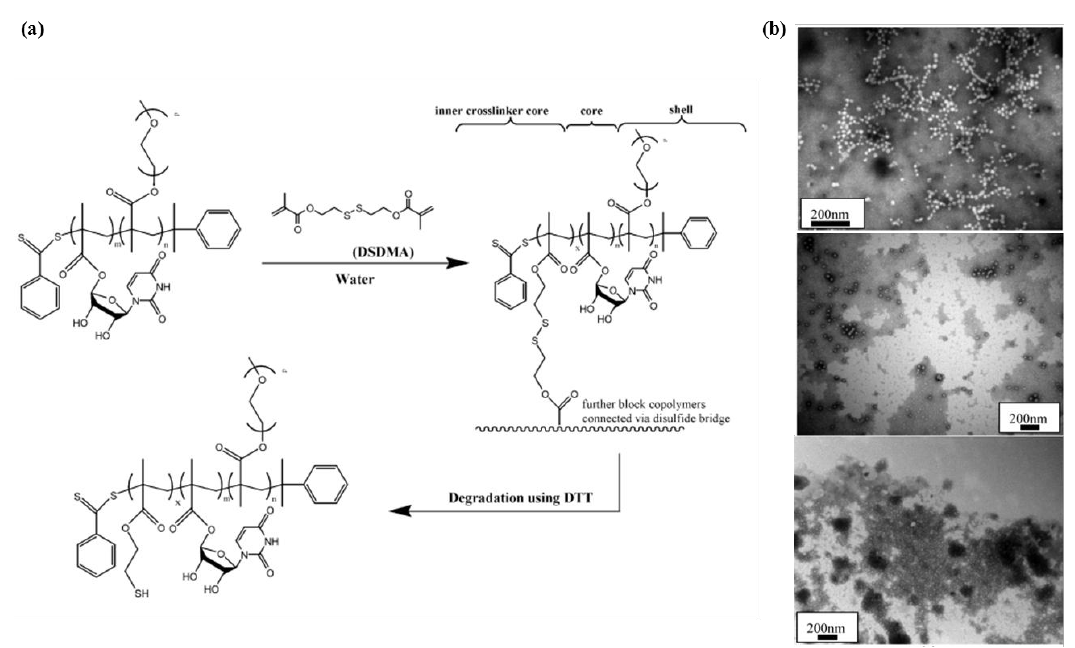
Figure 2. ( a ) Synthesis and Degradation of Core-Cross-Linked Micelles and ( b ) TEM images of ( top ) block copolymer PPEGMEMA - b -PMAU , ( middle ) core-cross-linked 30 80 micelles PPEGMEMA - b -PMAU - b -PDSDMA , ( bottom ) PPEGMEMA30- b - 30 80 2*45 PMAU80- b -PDSDMA after reduction with DTT, using phosphotungstic acid staining. 2*45 Reproduced from [26] with permission of [American Chemical Society